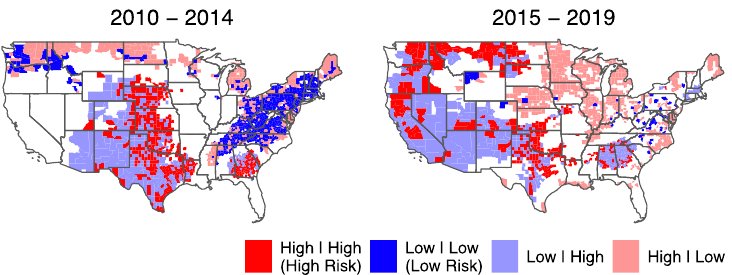
Figure 5. Total risks in each study period. Results of bivariate Local Moran’s I analysis with total vulnerability as the variable and total hazard as spatial lag. High (Low) indicates higher (lower) than the total average of the corresponding variable over all counties.